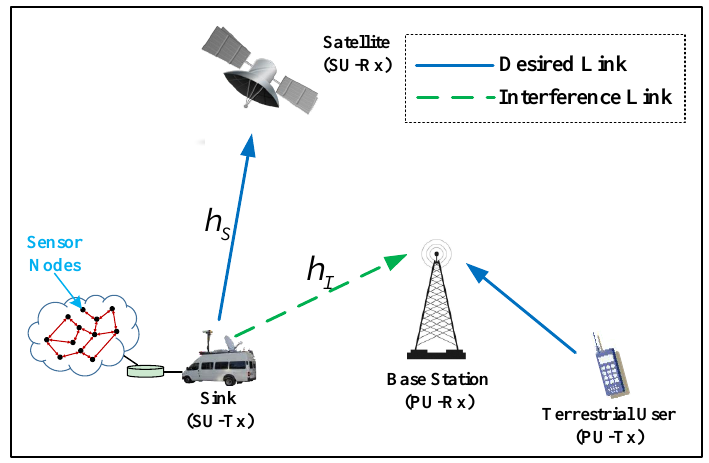
Figure 1. The architecture of the integrated wireless sensor and cognitive satellite terrestrial